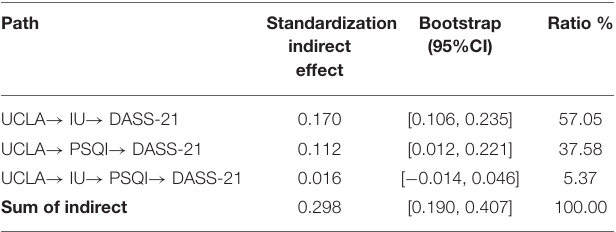
TABLE 3 | The mediating role of intolerance for uncertainty and sleep quality between loneliness and mental health.